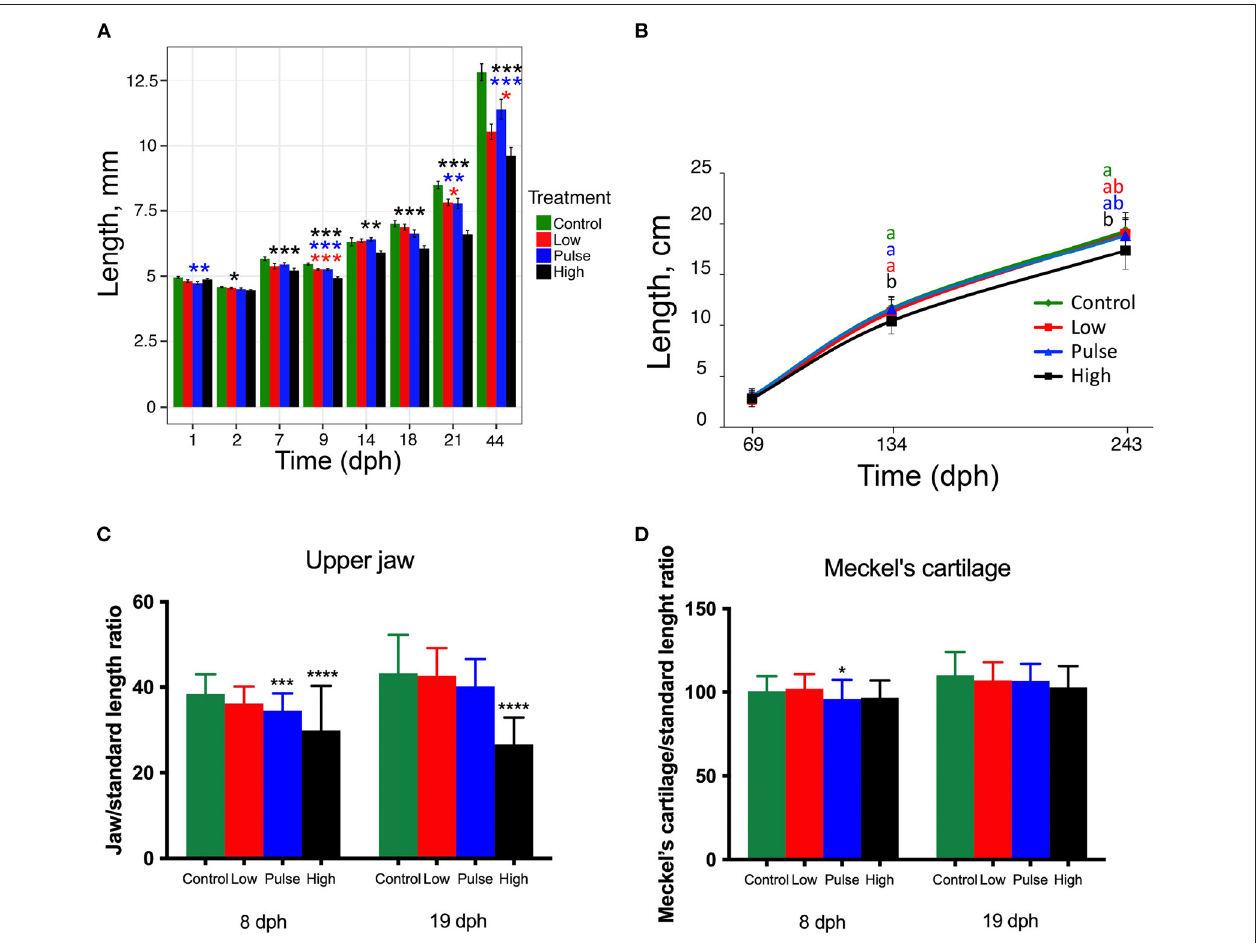
FIGURE 2 | Atlantic haddock larval and juvenile growth during and after oil exposure. (A) Length of haddock larvae and fry at 1–44 dph. (B) Length of juveniles at 69–243 dph after exposure termination. Normalized length of (C) upper jaw and of (D) Meckel’s cartilage in larvae exposed at 8 and 19 dph. Asterisks indicate